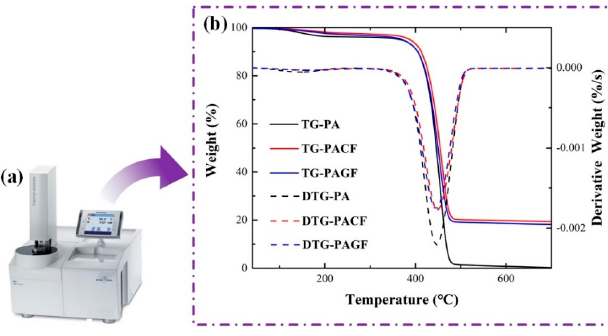
Figure 5. Thermogravimetric analysis (TGA): ( a ) Mettler TGA/DSC 3+; ( b ) results.